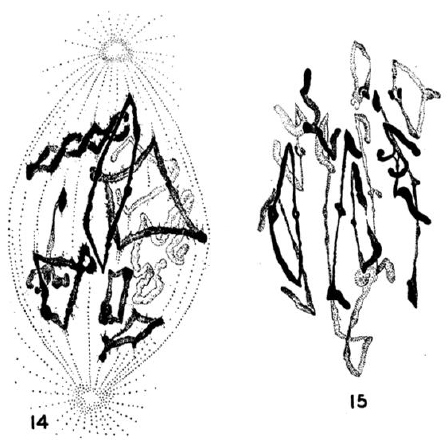
Figure 18. Typical pre-metaphase stretch of bivalent chromosomes in Stagmomantis carolina, a mantid. The kinetochores of homologous chromosomes are pulled far apart during Meiosis I in this species. 14 = early prometaphase, 15 is later. From Hughes-Schrader, 1943 [131]. With permission from the University of Chicago Press.